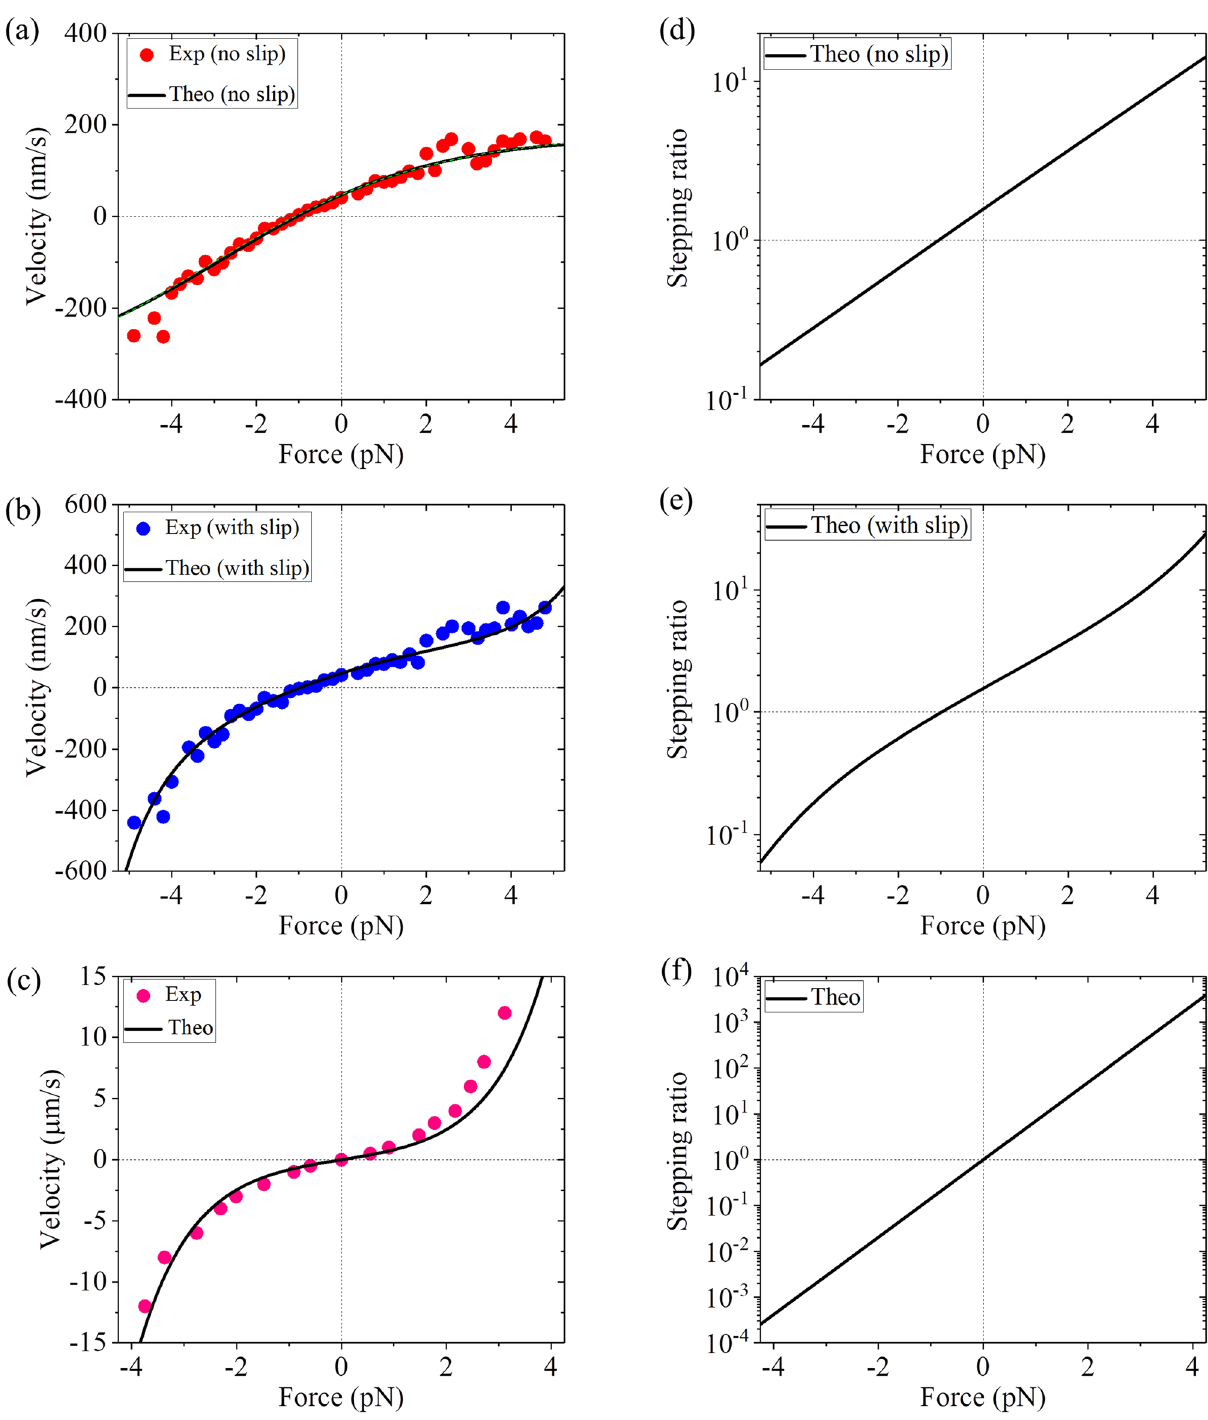
Figure 2. Results for dynamics of kinesin-8 Kip3 motor. ( a ) Velocity without including the slip versus load at saturating ATP. The experimental data (circles) are taken from Jannasch et al. 19 . The dashed green line, which is almost coincident with the black solid line, represents the results calculated using simple Eq. (6) and with four 1 parameters r 0 = 1.5, F S = 1.1 pN, k (+) = 23 s − and k (−) = 2.3 k (+) . ( b ) Velocity with including the slip versus load at saturating ATP. The experimental data (circles) are taken from Jannasch et al. 19 . ( c ) Slipping velocity versus load at saturating ADP and no ATP. The experimental data (circles) are taken from Bormuth et al. 20 . ( d ) Stepping ratio without including the slip versus load at saturating ATP. ( e ) Stepping ratio with including the slip versus load at saturating ATP. ( f ) Stepping ratio versus load at saturating ADP and no